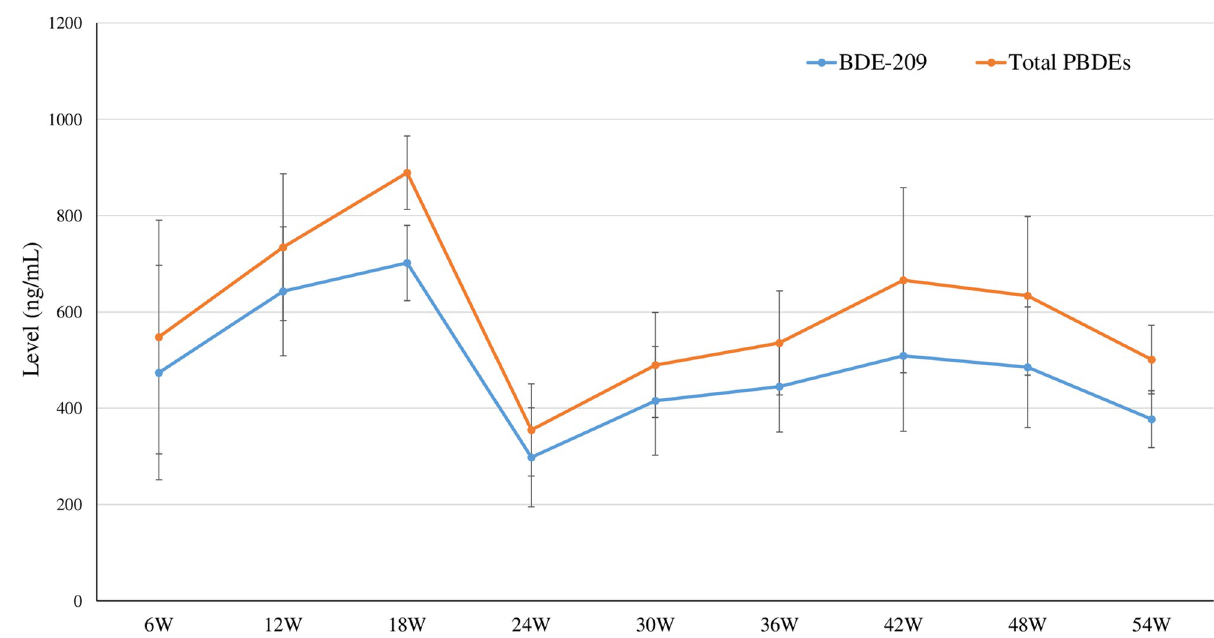
Fig 5. Time courses of serum BDE-209 and total PBDE levels (mean ± SD) in time courses of the BDE-209 treatment group.